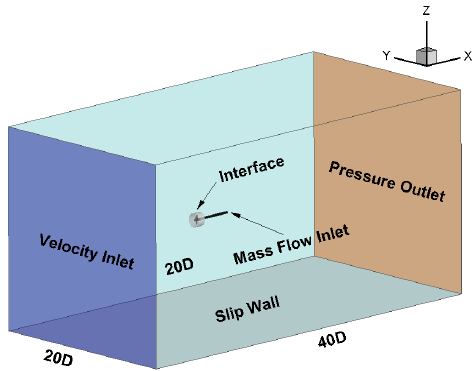
Figure 4. Computation domain and boundary conditions.